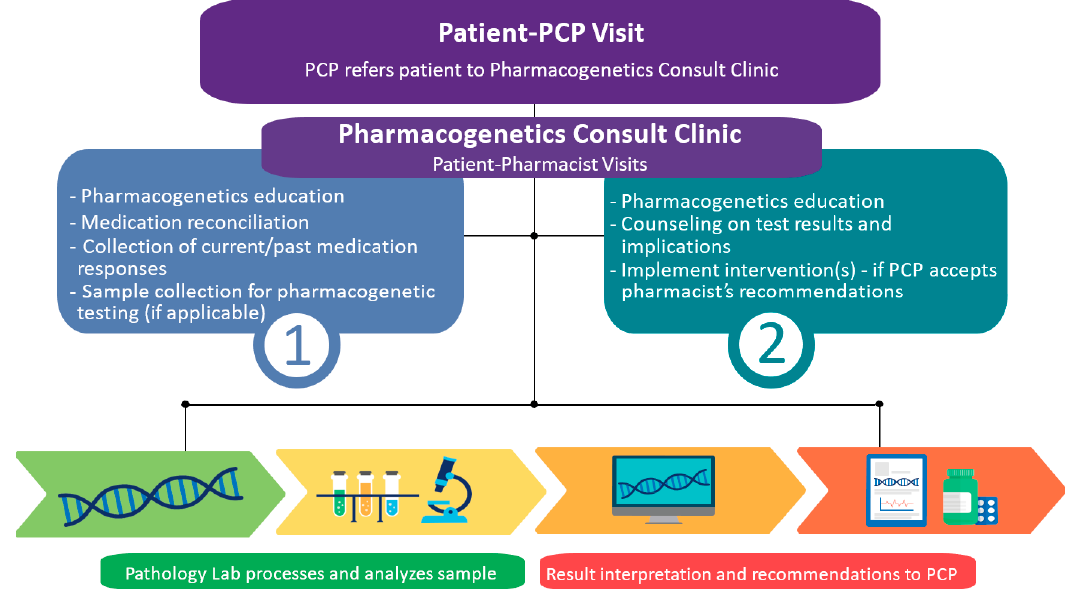
Figure 1. Clinical workflow of the pharmacogenetics consult